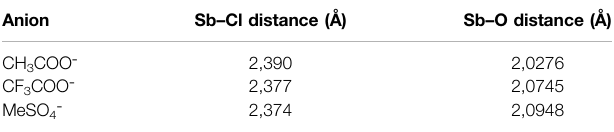
TABLE 2 | Average distance between antimony and chlorine and the distance of antimony and oxygen for a series of similar anions of ILs for the calculated geometries at the M06/6 – 31+g(d,p) (LanL2DZ for antimony) level of theory.